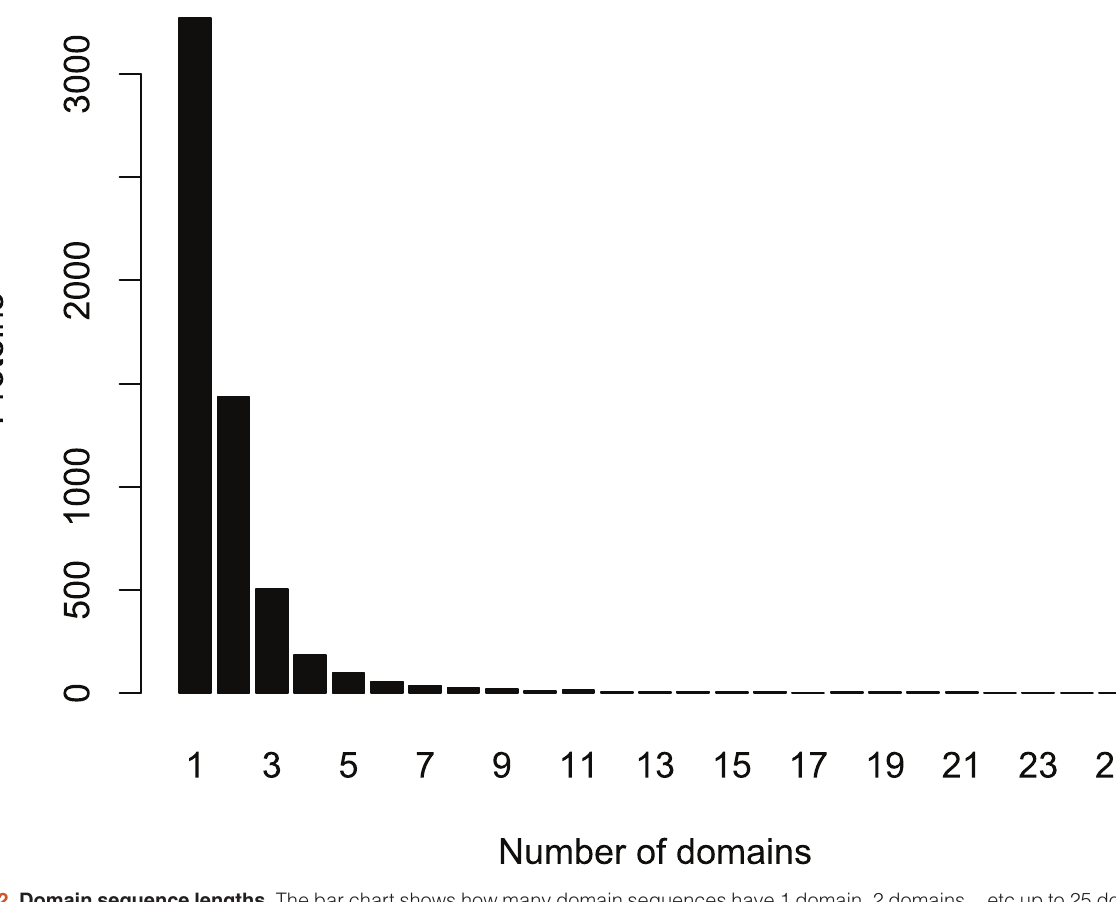
Figure 2. Domain sequence lengths. The bar chart shows how many domain sequences have 1 domain, 2 domains,...etc up to 25 domains. These are all non-overlapping hits in the protein. Single-domain proteins makes up more than half of the total number.